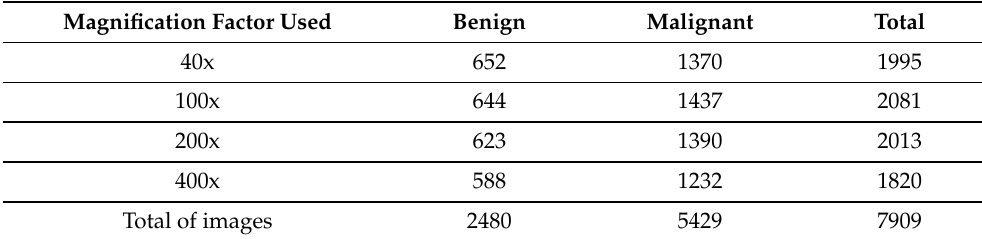
Table 1. Histopathological images dataset from